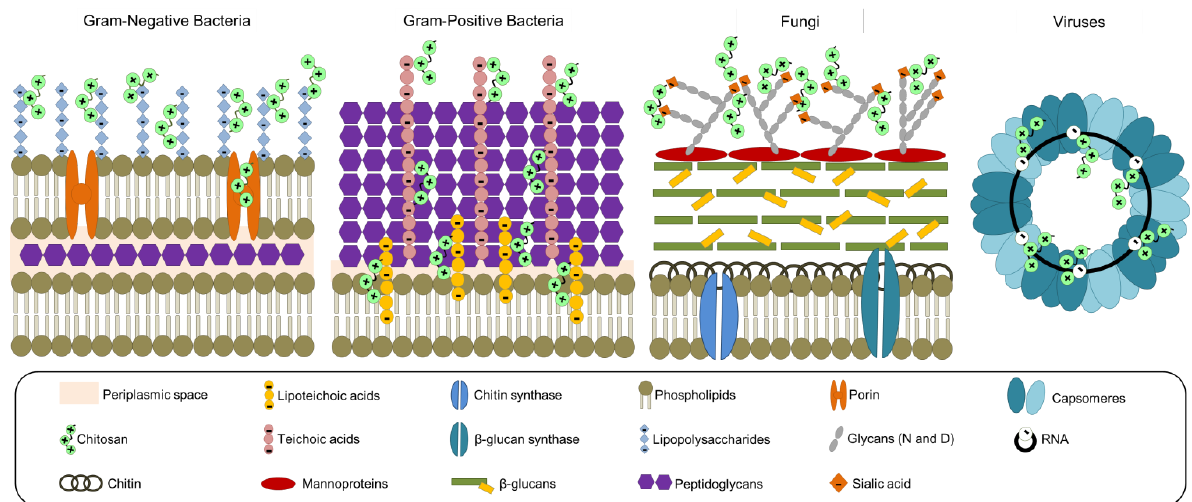
Figure 4. Proposed interactions and mechanism of action between chitosan and pathogens (Gram-positive and Gram- negative bacteria, fungi, and viruses). Adapted from References